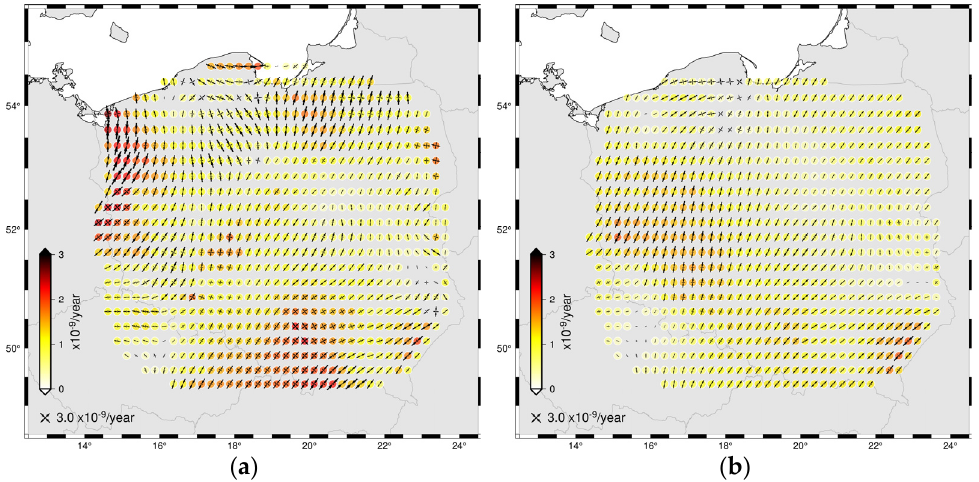
Figure 6. GPS strain rate maps including shear strain for DBF_100 ‐ 15 ( a ) and DBF_100 ‐ 25 ( b